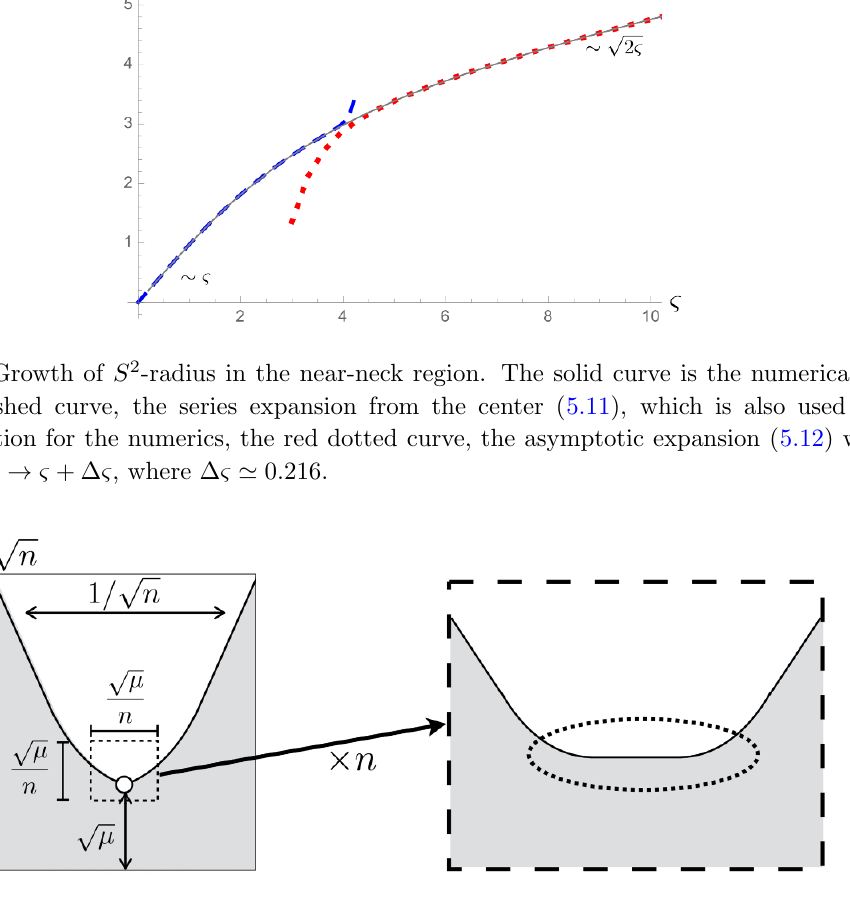
Figure 7 . Near-neck region. The left diagram is the neck region in the scaling of section 2. The right diagram is the blow-up of the near-neck region to obtain a smooth neck